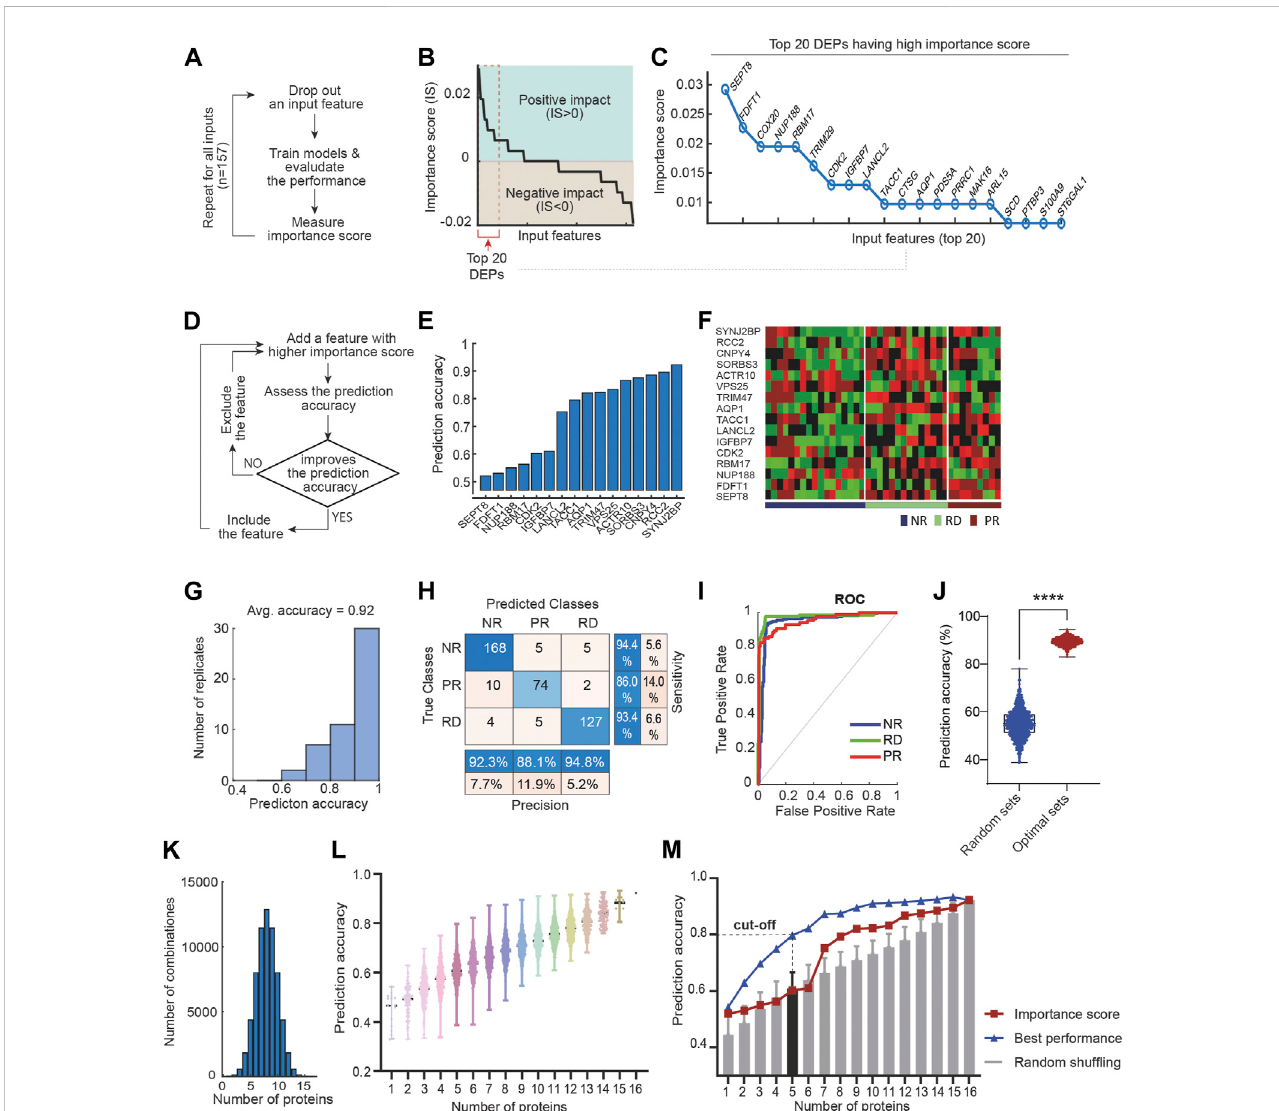
FIGURE 4 Rationalized feature selection optimizes ML model ’ s prediction accuracy. (A) A schematic of the drop-out analysis that enables calculation of the importance score (IS) for each feature. (B) Importance score values of all the DEPs, sorted in a descending order. IS > 0, < 0, and = 0 indicates proteins having negative-impact, positive-impact and no-impact on drug response prediction, respectively. (C) Top 20 of 157 DEPs having the highest importance score values. (D) A schematic work fl ow of our IS-based feature selection strategy. (E) Gradual incorporation of 16 proteins that ultimately leads to optimal prediction accuracy of drug response. (F) Heatmap displaying the expression data of the identi fi ed 16 marker proteins across the discovery PDE cohort. (G) Distribution of prediction accuracy performance across 50 model replicate runs. (H) Performance of the optimal mSVM classi fi er using the 16 DEPs as input features, summarized in a confusion matrix. (I) ROC curves of the mSVM classi fi er for the RD, NR and PR response groups. (J) Comparison of performance between the optimal mSVM model and models using 16 randomly selected features (from 157 DEPs); **** p -value < 0.0001 (unpaired t -test, n = 1,000). (K) Tally ofpossible combinations of proteins with increasing size ranging from 1 to 16. (L) Prediction accuracy signi fi cantly varies depending on thecombination speci fi cation of input features. (M) Performance comparison between the optimal model and those with randomly selected features (shuf fl ed from the 16 identi fi ed biomarkers), displayed for increasing panel